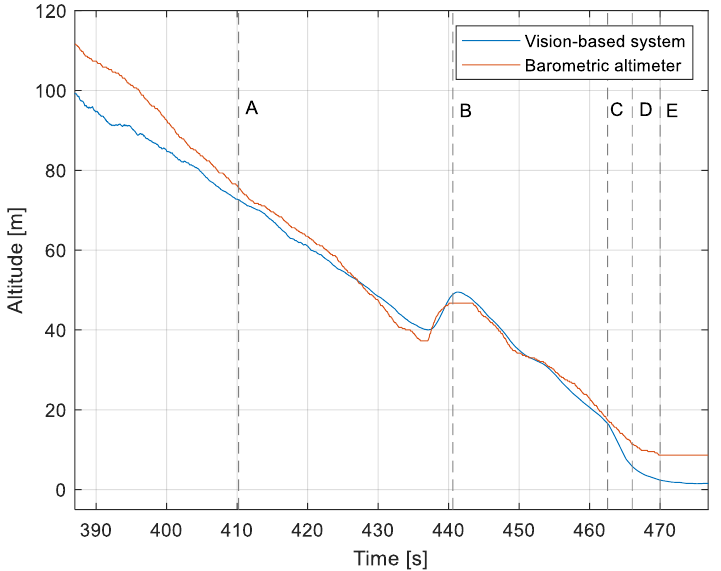
Figure 10. Altitude relative to the airside: Flight no. 2 (markers A–E correspond to the moment of recording the images in Figure 11).